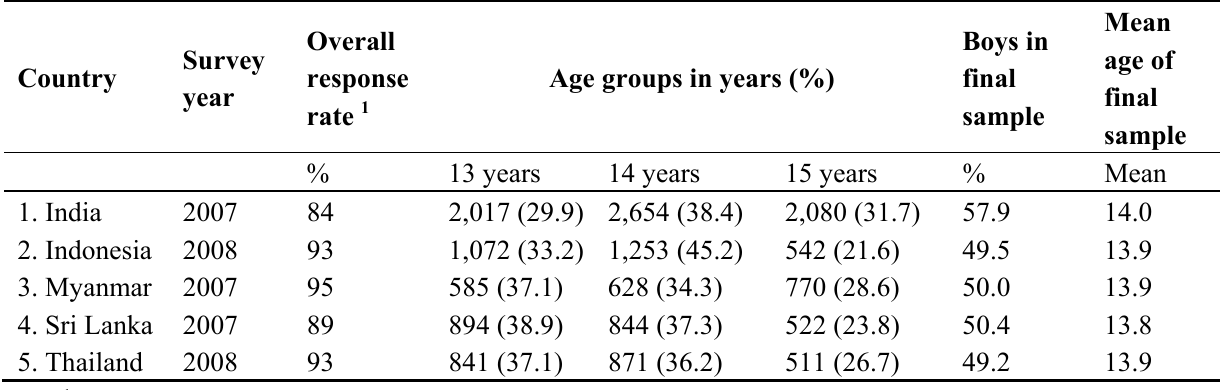
Table 1. Sample response rate and age distribution of students surveyed; GSHS